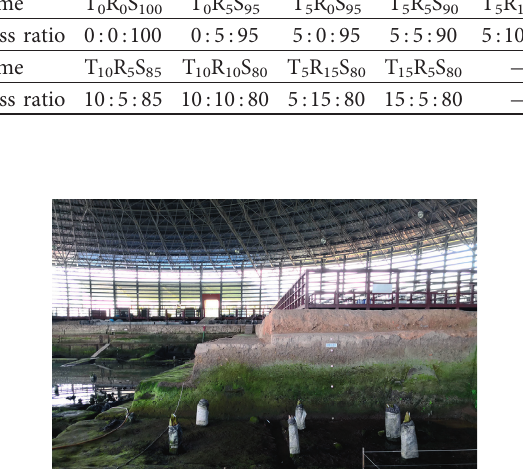
Figure 7: Shear strength indexes of the treated soil